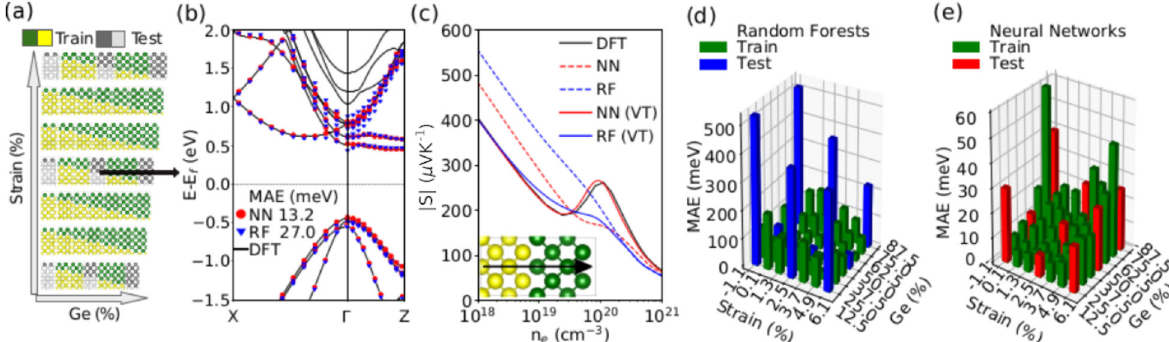
Fig. 3 Testing ML algorithms on strained superlattices, same size as training units. a Representative con fi gurations of 16-atom train and test units: ideal superlattices (SL) with varied compositions and external strain. Colored and gray cartoons represent train and test units, respectively. Each con fi guration is subjected to global in-plane substrate strains of varied magnitude. The unit structure in the middle correspond to a relaxed Si 4 Ge 4 SL (see arrow). b Energy bands of relaxed Si 4 Ge 4 SL calculated with DFT (black solid lines) and predicted by neural network (NN) (red circle) and random forests (RF) (blue inverted triangle) algorithms. c Thermopower calculated from bands obtained with DFT (black solid line) and predicted by NN (red) and RF (blue) algorithms. Dashed and solid lines represent predictions from ML models